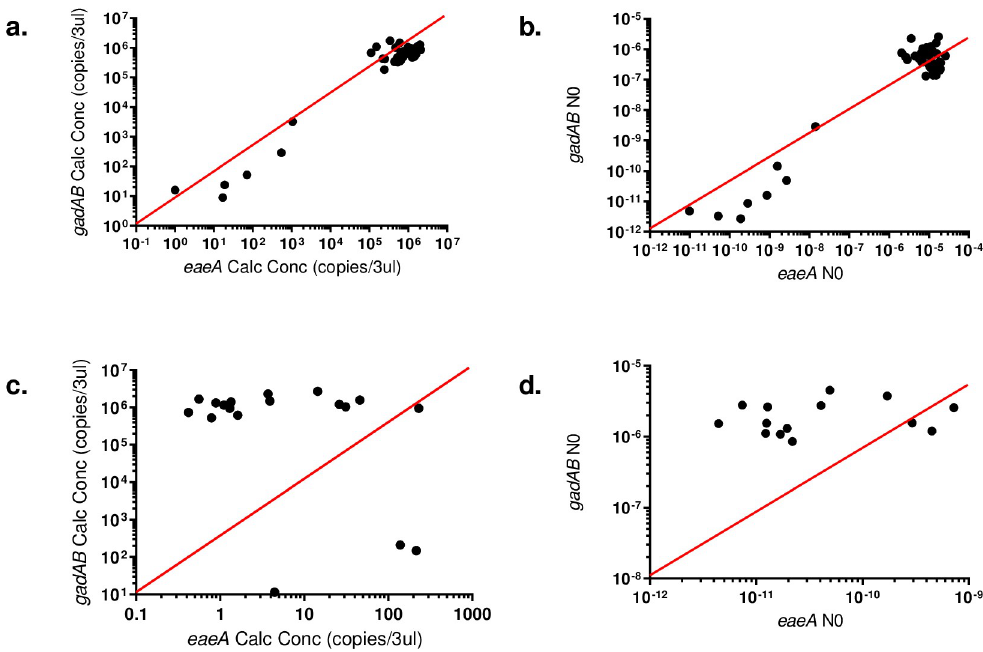
Fig 2. Graphs depicting the gadAB vs eaeA copies for the 2005–2006 clinical strains (a) and 2008–2009 clinical strains (c) drawn with the Corbett Research Thermal cycler software and gadAB vs eaeA N0 calculated with the LinRegPCR software for the 2005–2006 clinical strains (b) and 2008–2009 clinical strains (c). The red reference line in each graph indicates in each graph is when x = y.